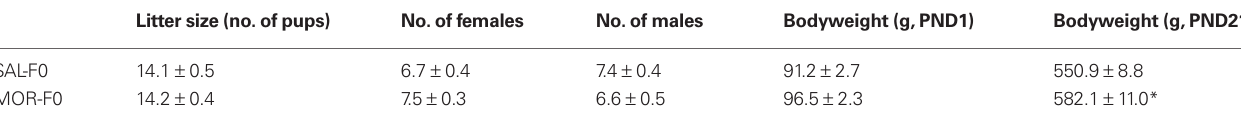
Table 1 | The effects of adolescent morphine exposure on postnatal parameters.